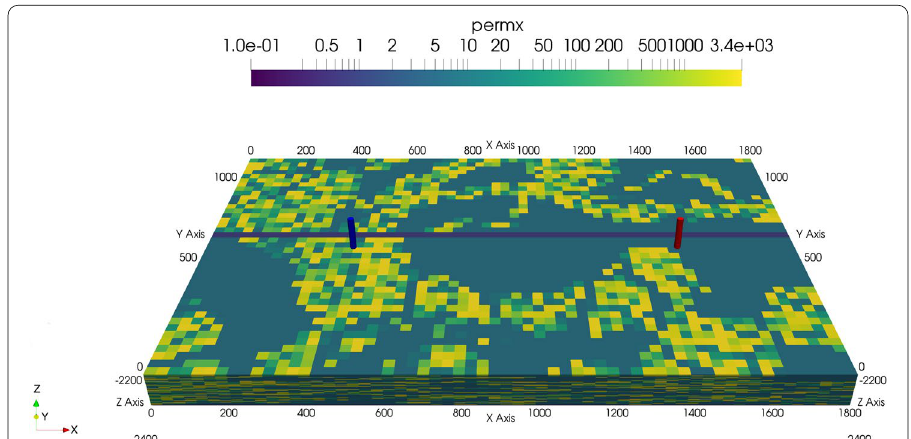
Fig. 4 Map view of the 3D reservoir model of the heterogeneous Delft Sandstone. The injection well is indicated in blue and the production well indicated red, well spacing is 990 m. Each cell is 30 m by 30 m by 2.5 m ( x , y , z ). The vertical fault is indicated by the purple line (shown here with a permeability of 0.75 mD), has a width of 30 m and extends throughout the domain along the x -axis. The different fault permeability